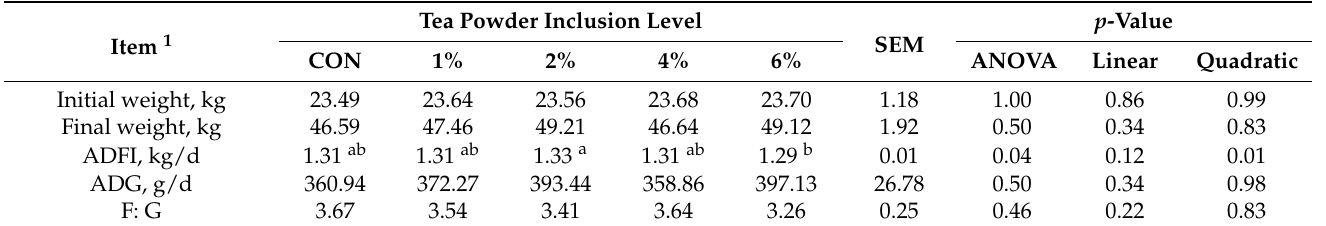
Table 4. Effects of dietary supplements with tea powder on growth performance of the